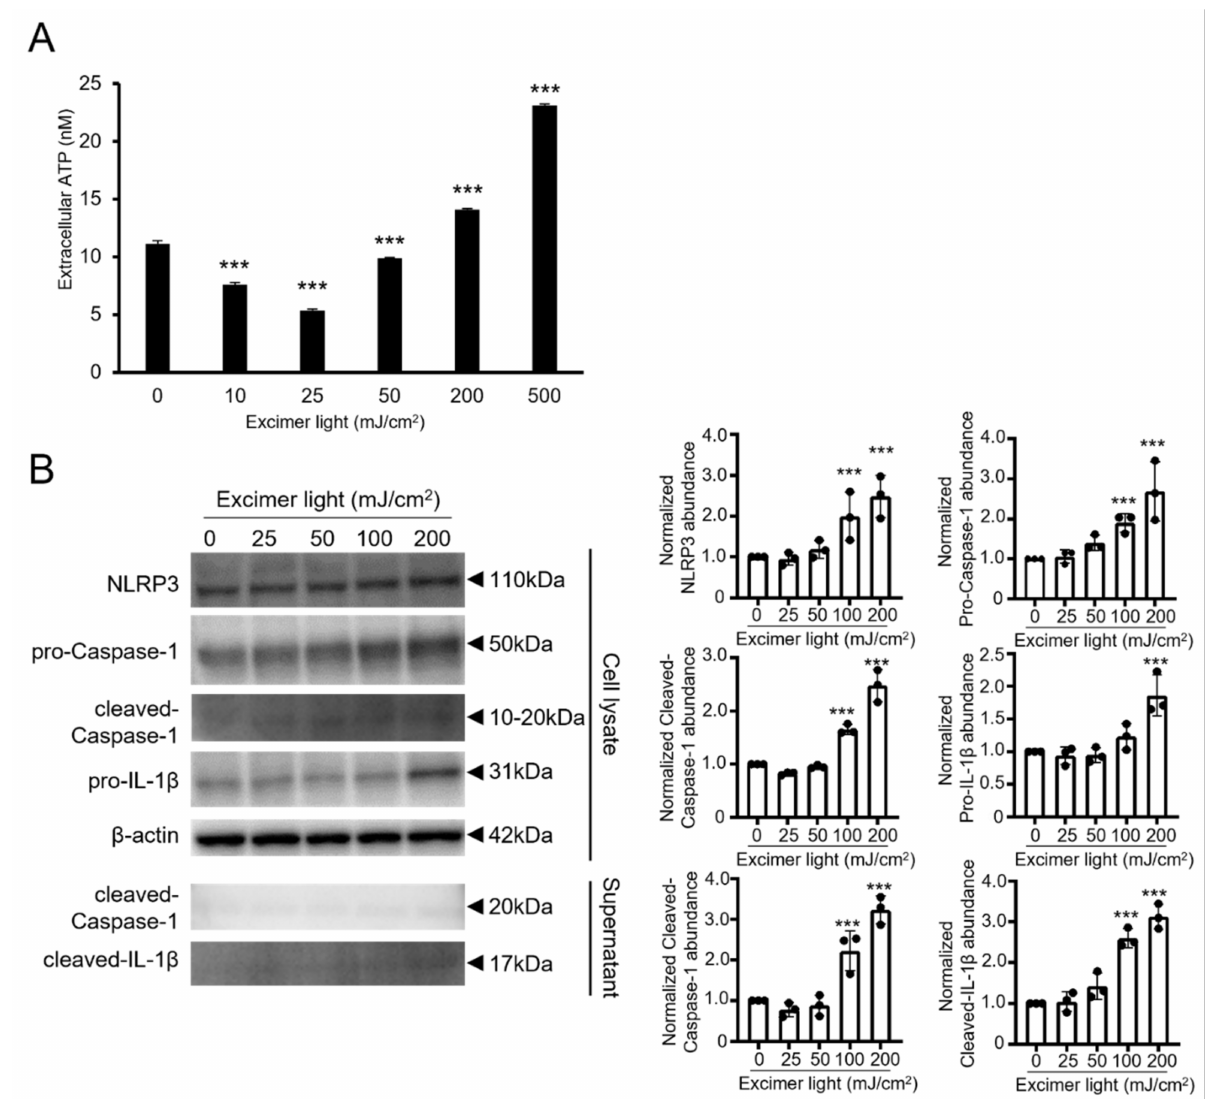
Figure 3. Monochromatic excimer light (MEL) irradiation altered extracellular ATP release and inflammasome activation in PSVK1 keratinocytes. ( A ) Extracellular ATP release was quantitated in the culture supernatant by an ATP quantitation assay after 2 h irradiation using the indicated dose of MEL. ( B ) The protein expressions of NLRP3, pro- and cleaved caspase-1, and pro-IL-1 β in PSVK1 cell lysates and cleaved caspase-1 and IL-1 β in the culture supernatant using Western blot analyses after 24 h irradiation with the indicated dose of MEL. The graph (right panel) shows averaged abundance normalized to β -actin by densitometry analysis of western blot bands. Data are shown as the means ± SD, *** p < 0.01 one-way analysis of variance followed by Dunnett’s test vs. 0 mJ/cm 2